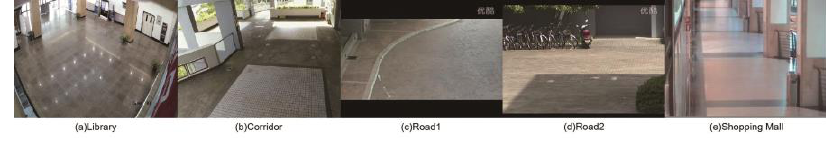
Fig. 6. Dataset scenario